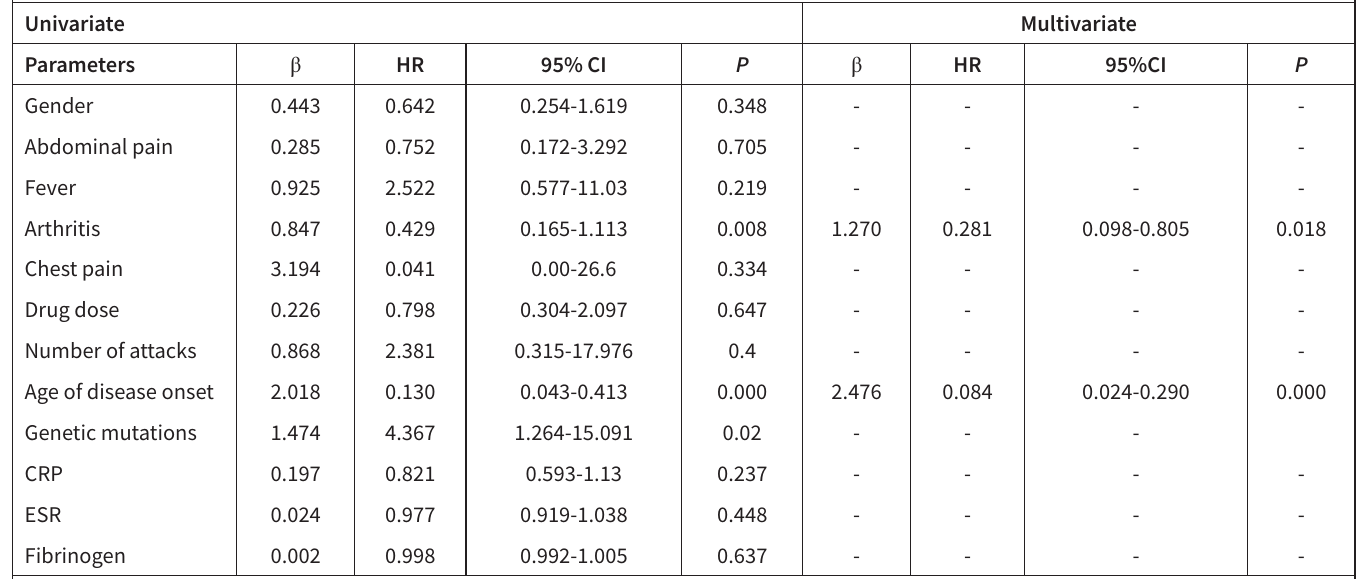
Table 3. Cox Regression Analysis of Risk Factors Affecting CKD in FMF Patients